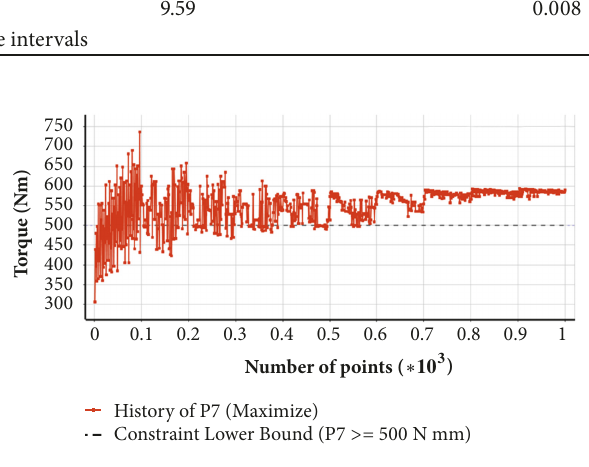
Figure 9: History chart of the